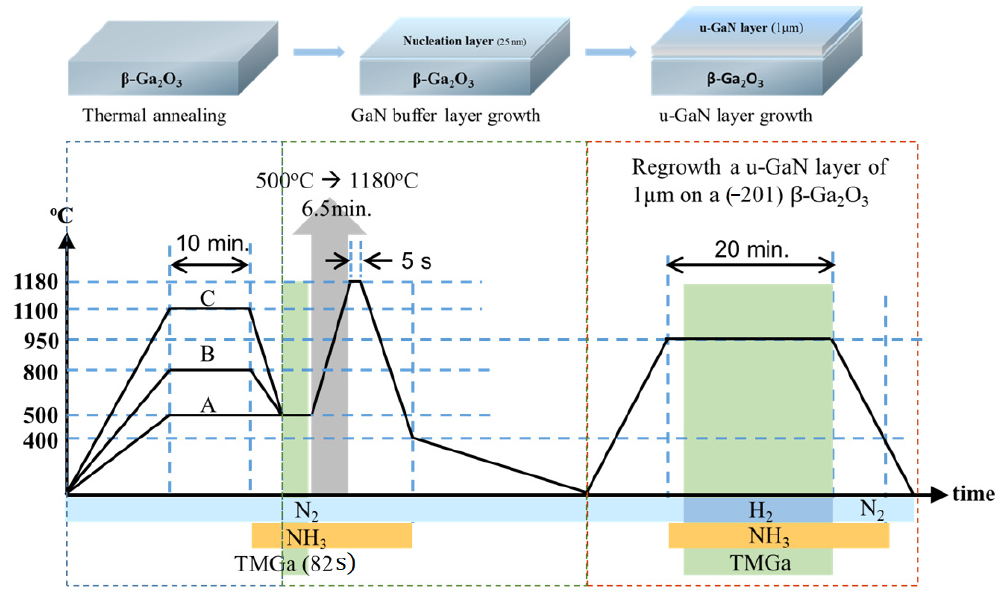
Figure 1. The growth sequence of the GaN epilayer on a ( − 2 0 1) β -Ga 2 O 3 single-crystal wafer. Thermal annealing of the cleaned wafer was taken at different temperatures, before sequentially deposing the GaN buffer layer and u-GaN